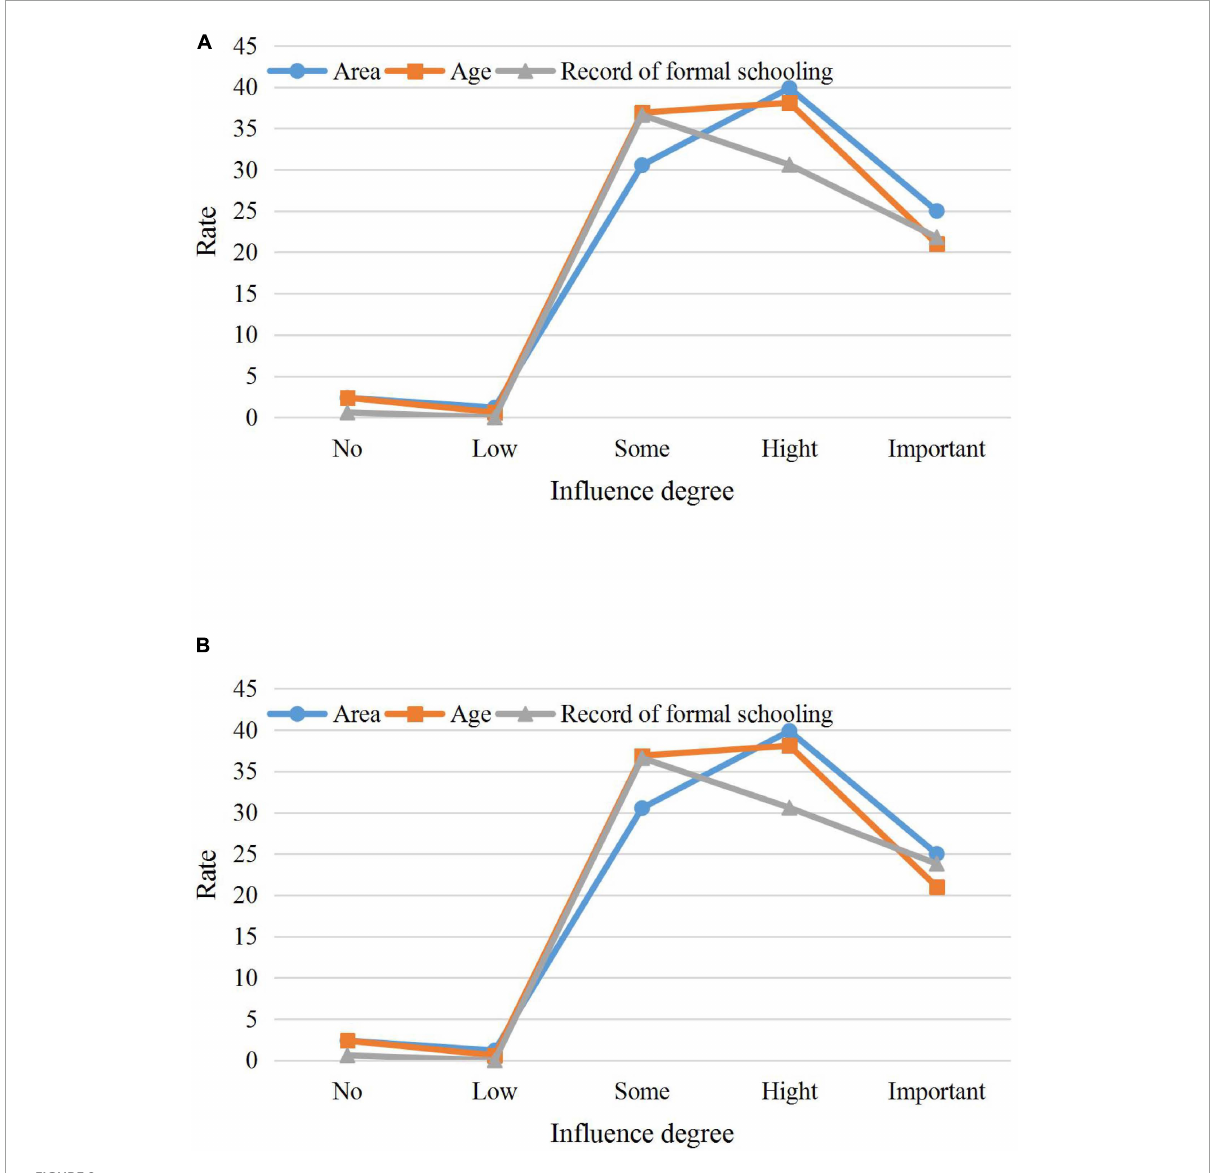
FIGURE9 The questionnaire results. (A) The first test result; (B) The second test